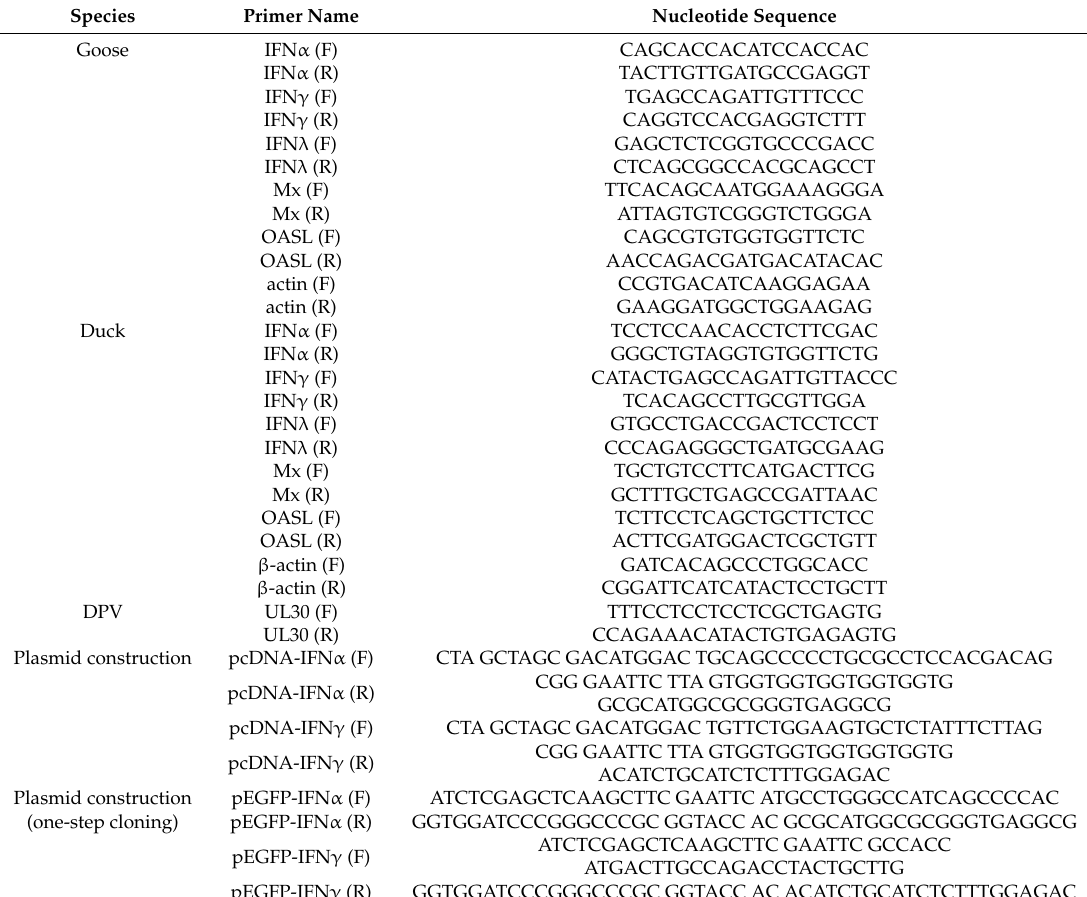
Table 1. List of primers used in this study and their